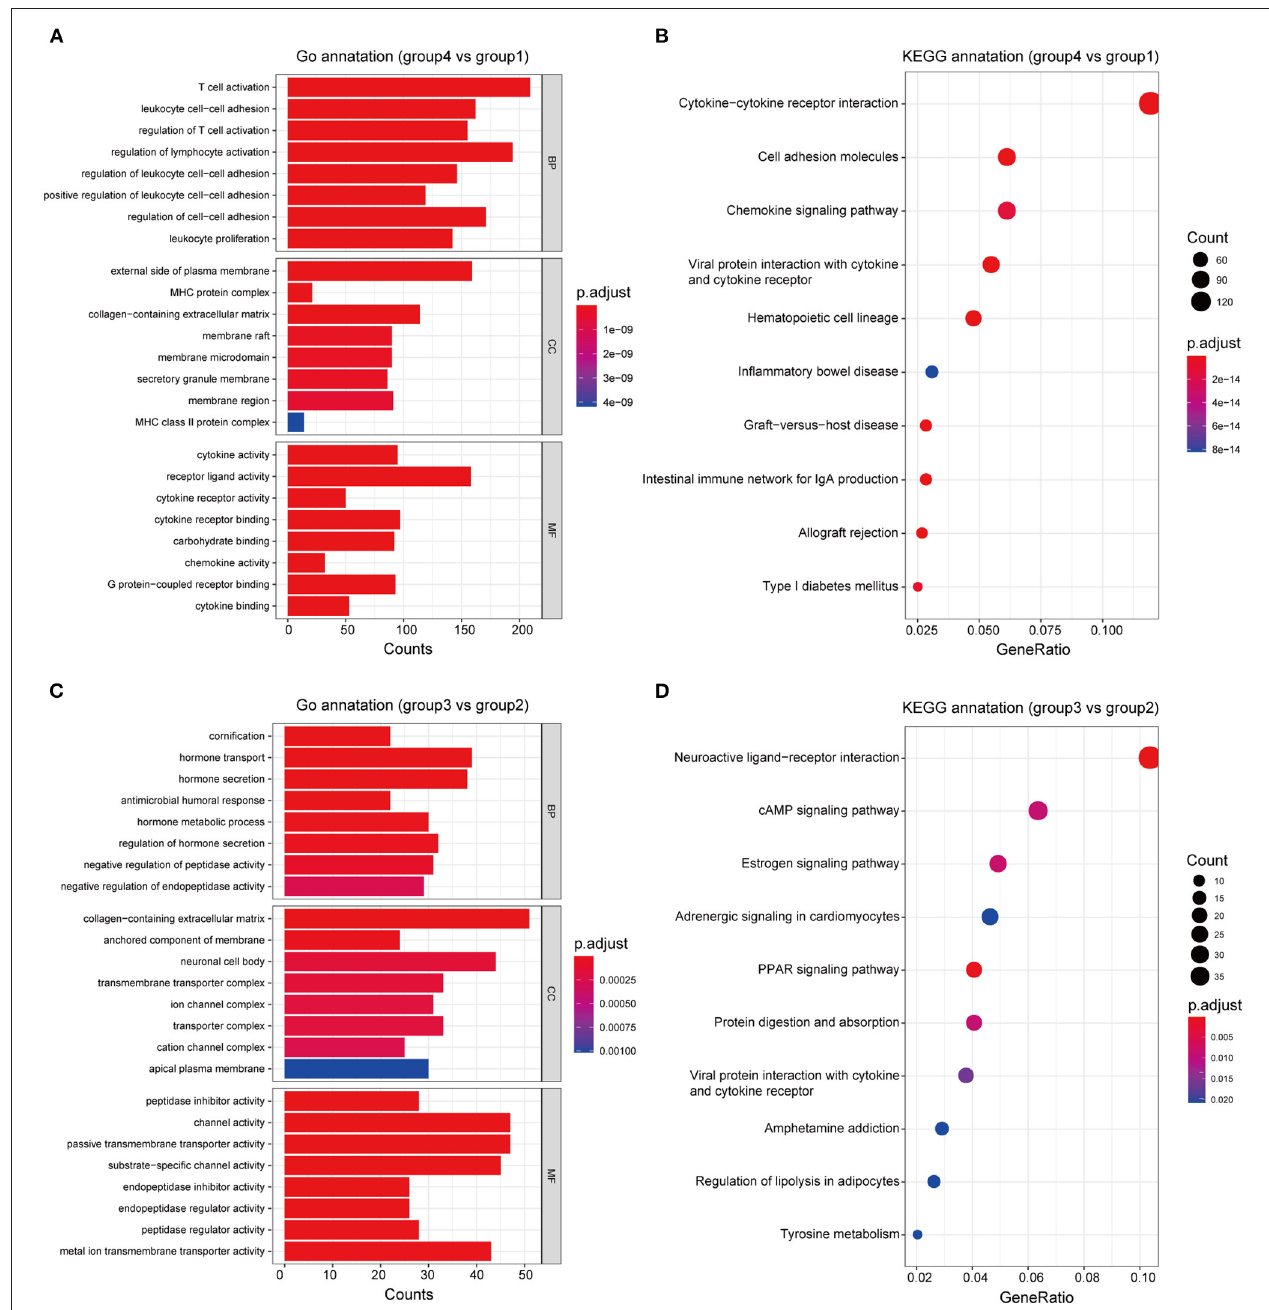
FIGURE 6 | Functional annotation of the subgroups. GO and KEGG enrichment analyses, respectively, revealed the significantly associated processes and signaling pathways with differences in immune response between groups 4 and 1 (A,B) , and between groups 3 and 2 (C,D)